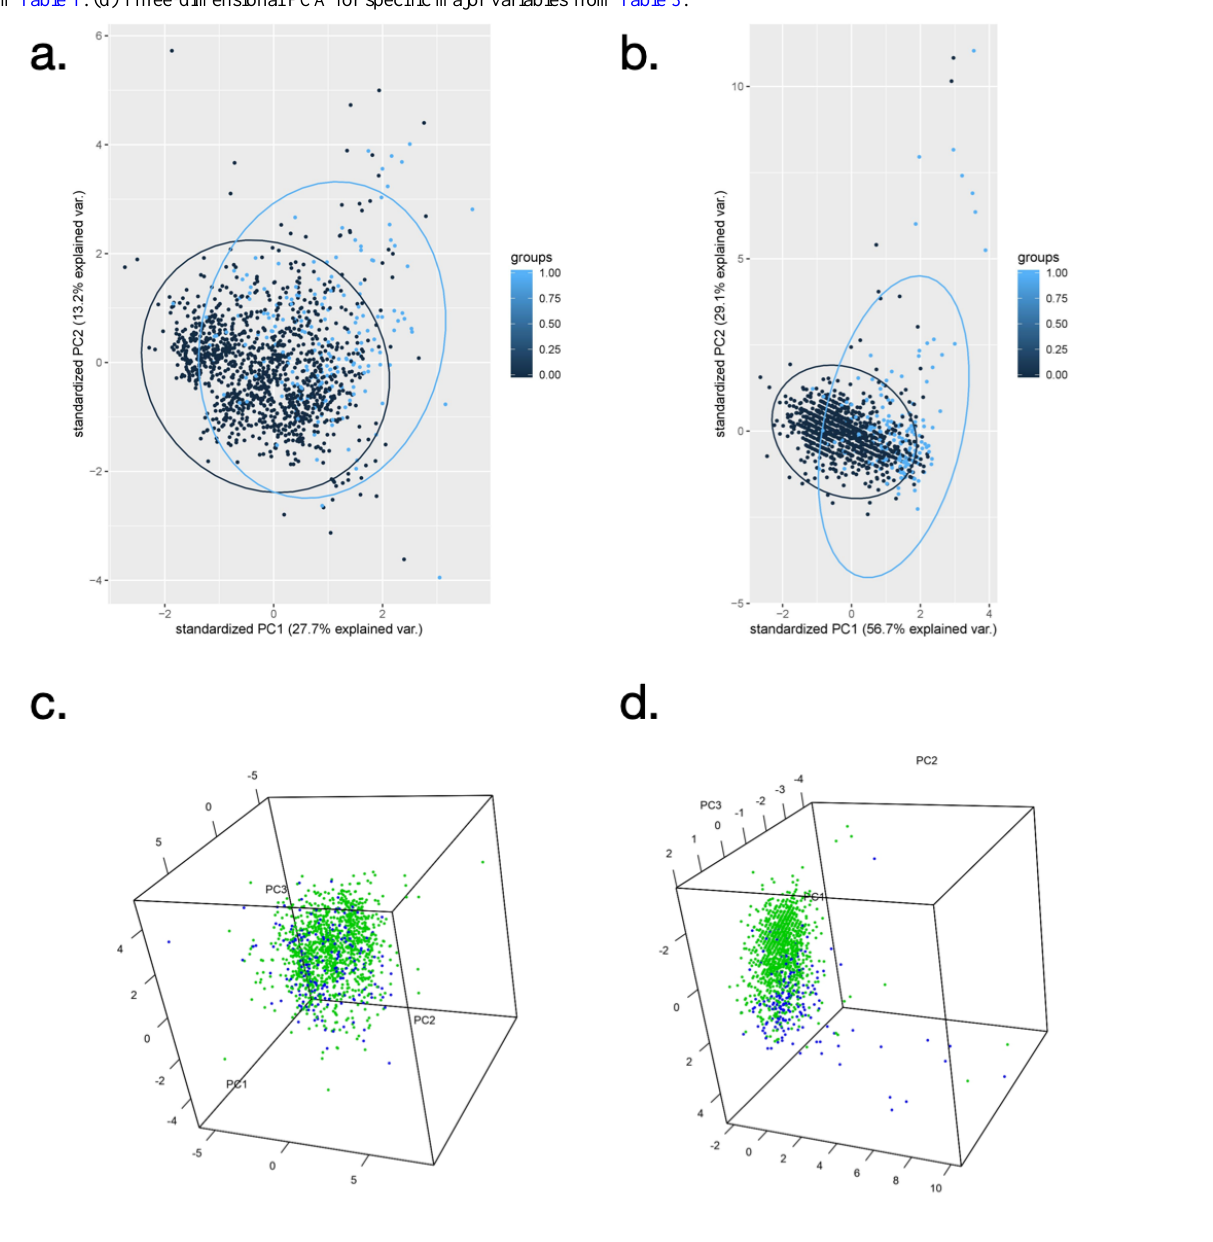
Figure 2. Principal components analysis (PCA) of metabolic and nonmetabolic groups by two-dimensional and three-dimensional visualization. (a) PCA with 95% CI shown as ellipses for all risk factors in Table 1. (b) PCA with 95% CI shown as ellipses for specific major variables in Table 3. Light blue nodes represent people diagnosed with metabolic syndrome, and dark blue nodes represent people without metabolic syndrome. PC1 explains the most variability among the samples, followed by PC2, PC3, and so on. (c) Three-dimensional PCA including PC1, PC2, and PC3 for all risk factor data from Table 1. (d) Three-dimensional PCA for specific major variables from Table